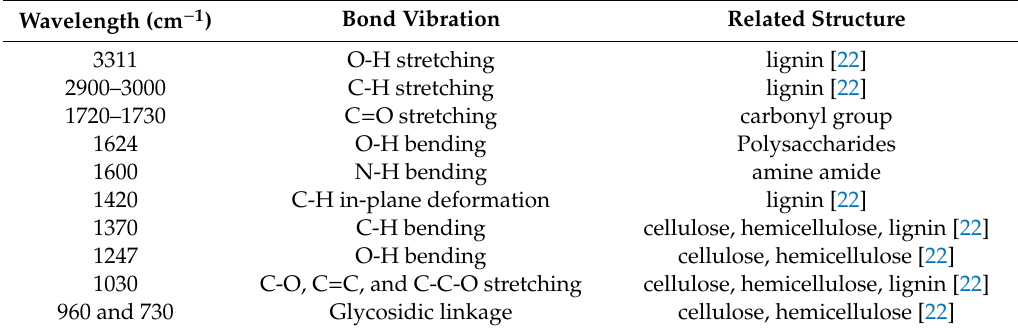
Table 2. FTIR analysis of functional